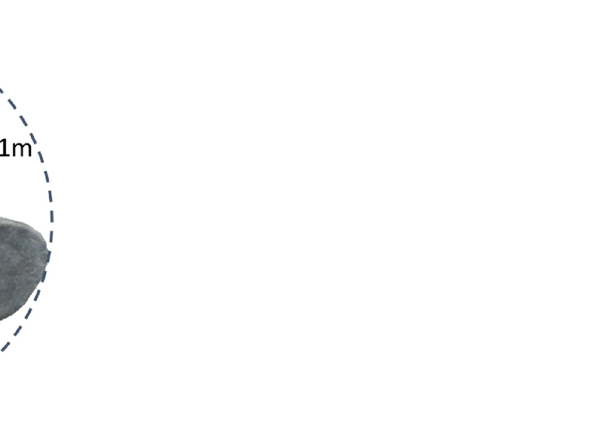
Figure 12. One-meter diameter cruise ship propeller made with WAAM in the laboratory.